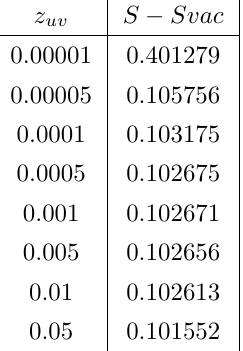
Table 2 . The regulated entanglement entropy at various cutoff surfaces for l = 0 . 4 in the transverse direction. We can see variation on the order of 10 − 4